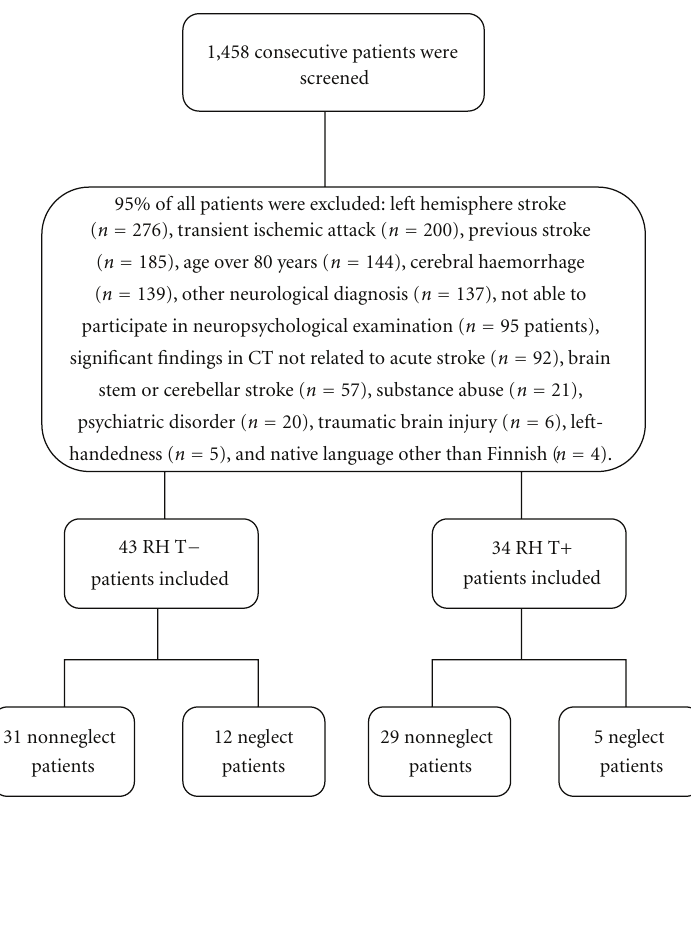
Figure 1: Selection of acute ischemic right hemisphere (RH) stroke patients with (T+) or without (T − ) thrombolytic